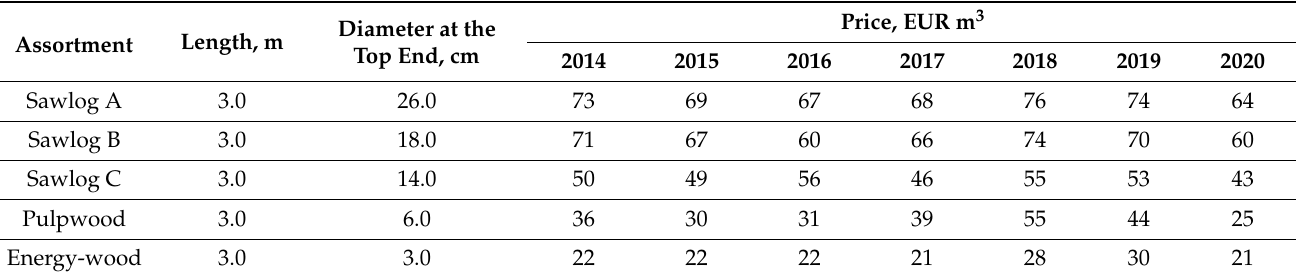
Table 1. The assortments by diameter at the top end and monetary value during the period from 2014 to 2020. Assortment Length, m